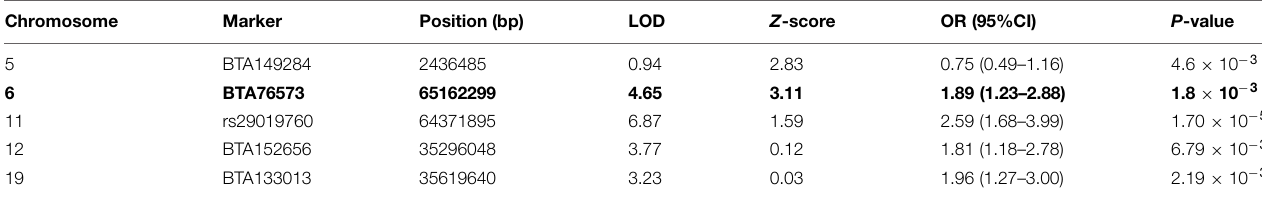
TABLE 1 | SNPs showing the strongest genetic background in the tuberculin positivity association analysis. Chromosome Marker Position (bp) LOD Z -score OR (95%CI) P